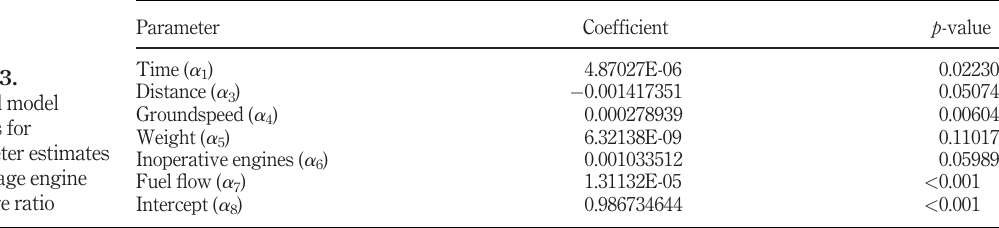
outputs for parameter estimates of average